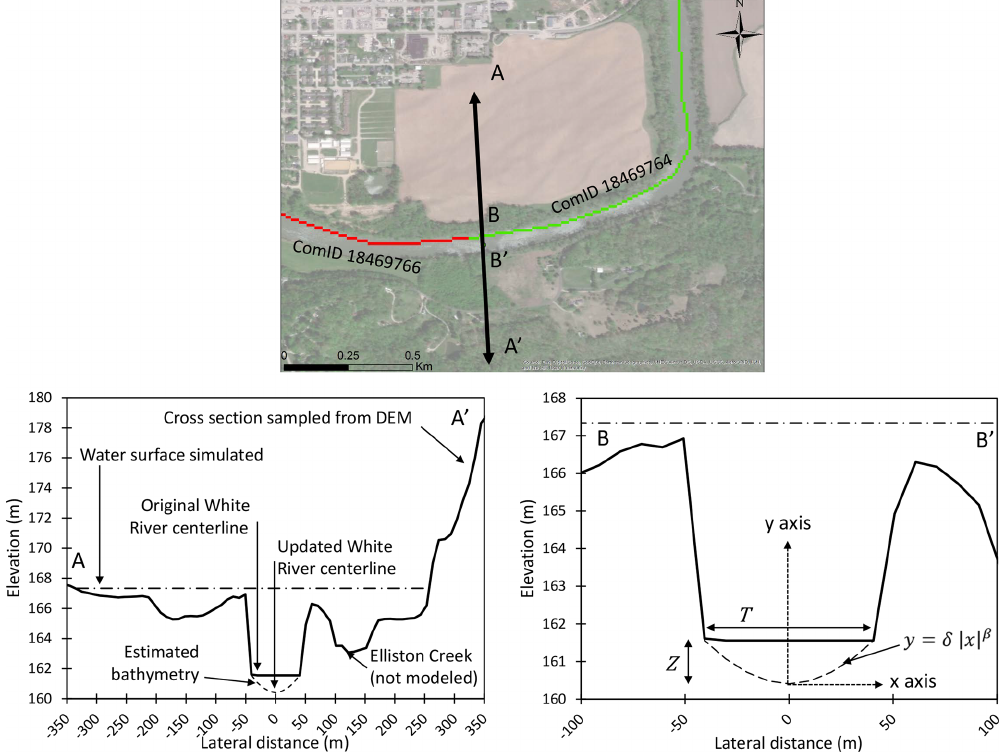
Figure 1. Cross-section profile of the White River near Spencer, IN. Also shown is the bathymetry estimation where T is the top width of the channel, Z is the maximum depth of the bathymetry profile, and y and x are the ordinates of the bathymetry profile. Sources of the background imagery include ESRI, DigitalGlobe, Earthstar Geographics, CNES/Airbus DS, GeoEye, USDA FSA, USGS, Getmapping, Aerogrid, IGN, IGP, and the GIS user